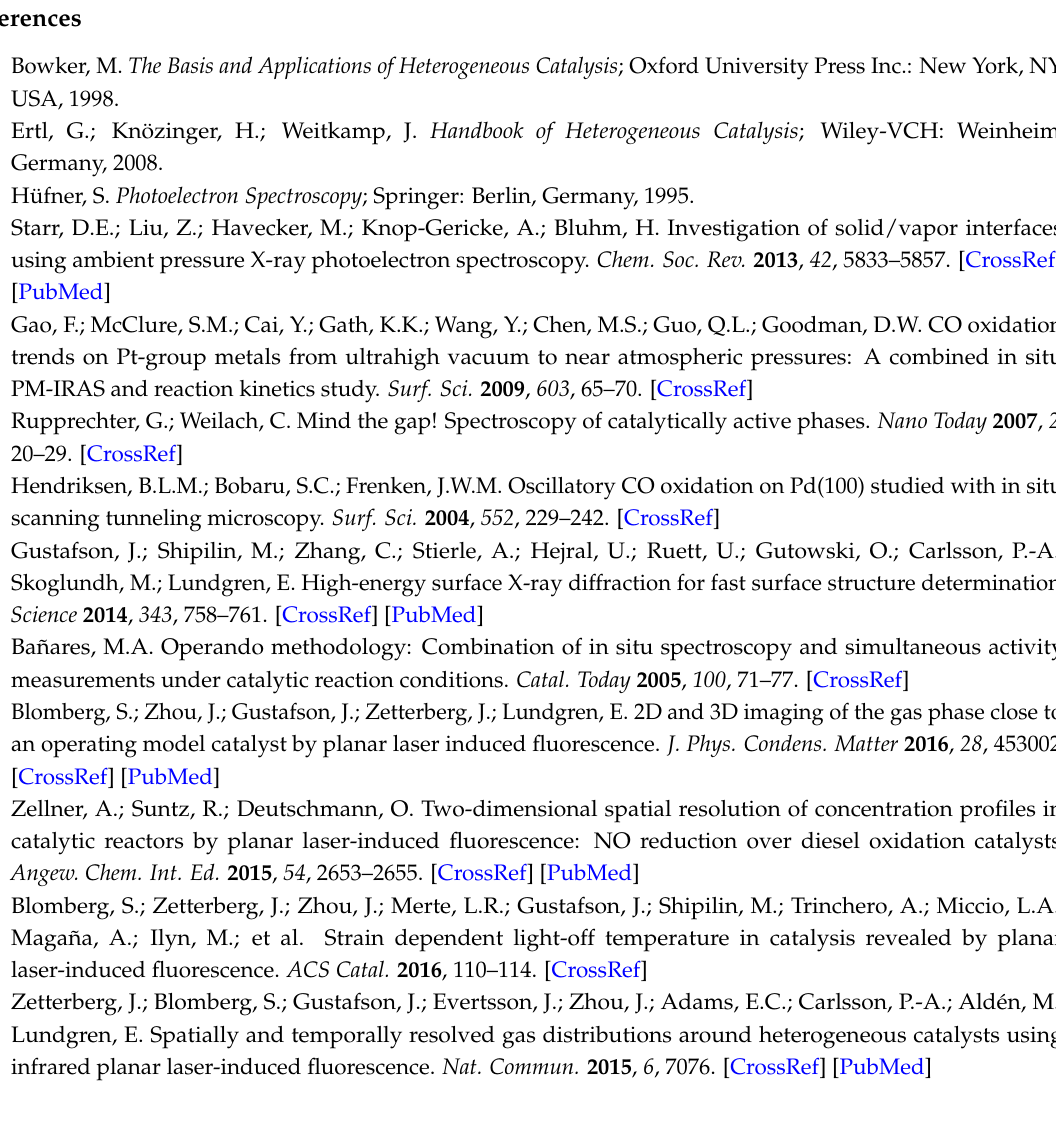
Figure S1: Schematic of the reaction system, Video S1: Movie_reactor with a nozzle, Video S2: Movie_reactor without a